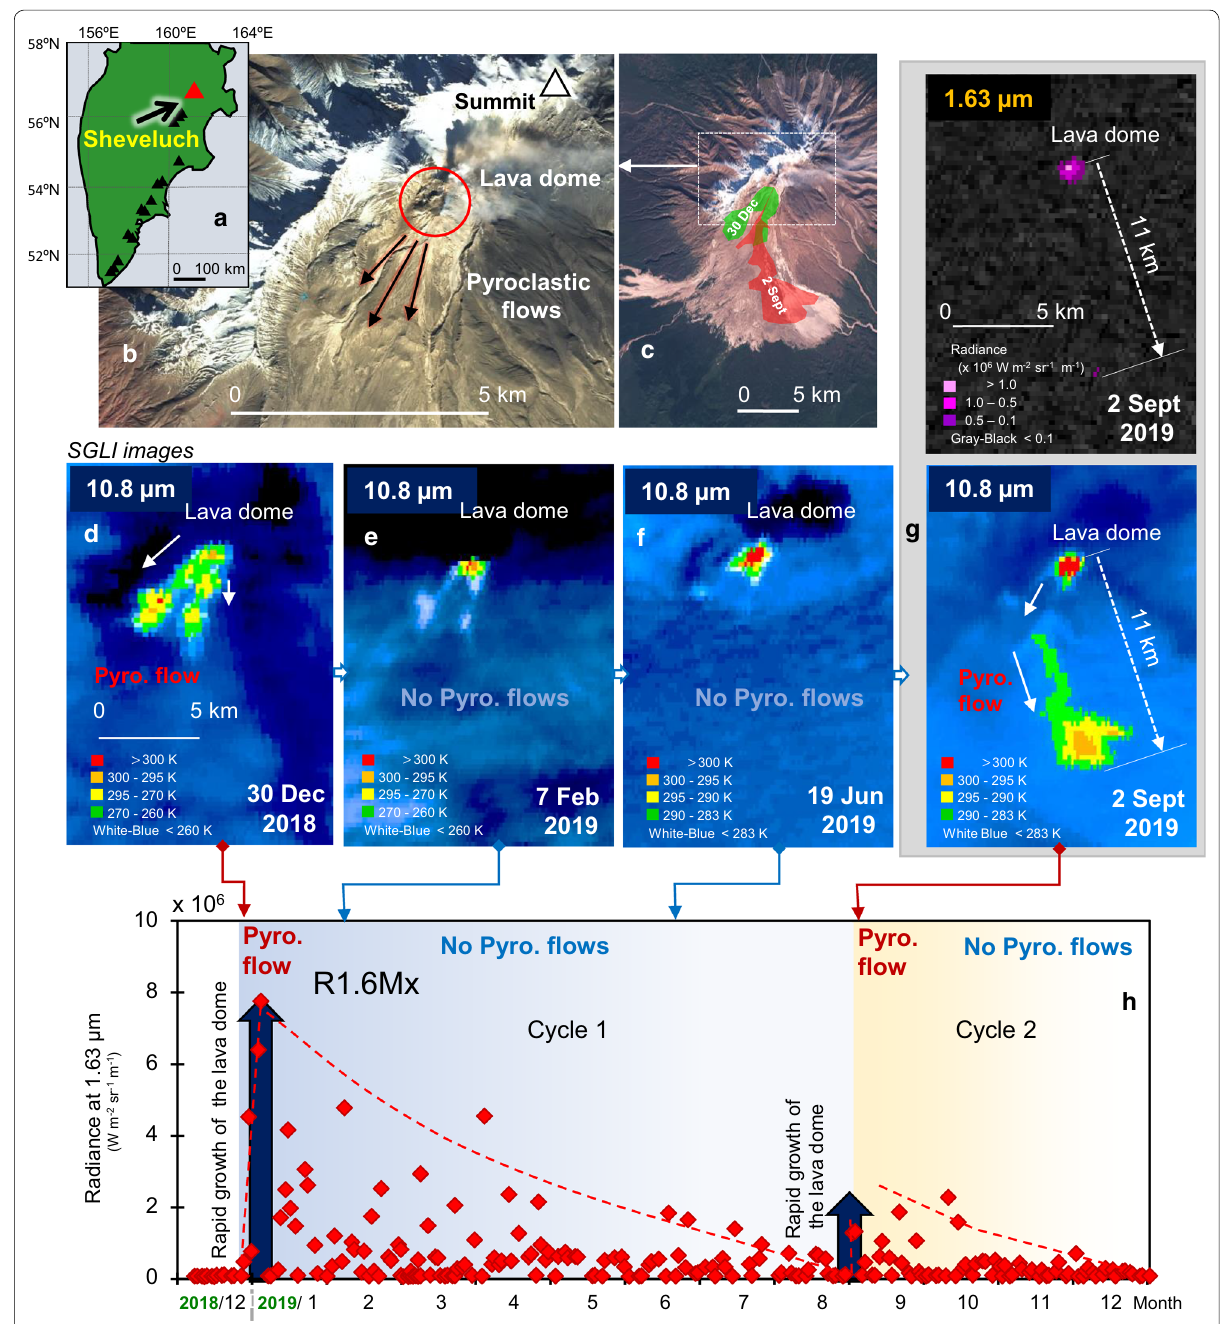
Fig. 4 a Location of the Sheveluch volcano. b Location of the active lava dome (Sentinel-2 image). c Summit area of the Sheveluch volcano (Sentinel-2 image). d – g SGLI images between December 2018 and December 2019. Pyroclastic flows are recognized in the images of 30 December 2018 and 2 September 2019. h Time-series variation of thermal anomaly (R1.6Mx) detected by the 1.63 µm band of the SGLI between